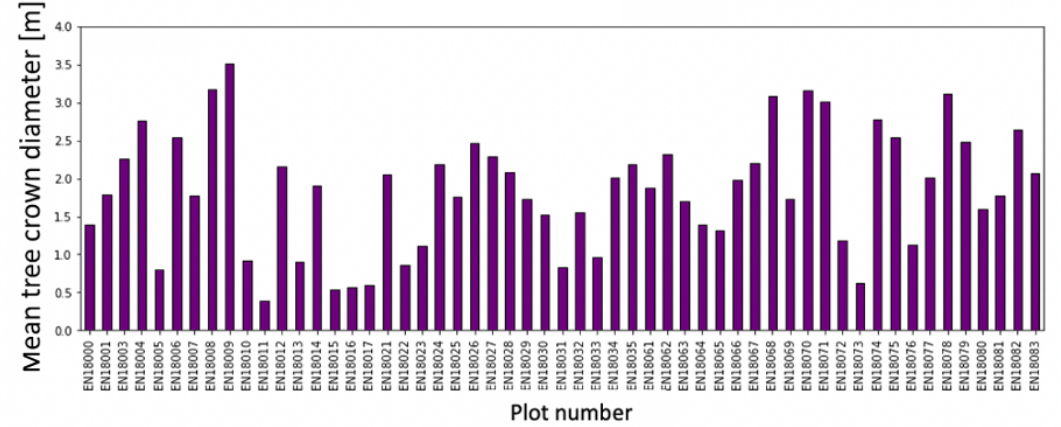
Figure A6. Mean tree-crown diameter (m) per plot from fieldwork measurements.